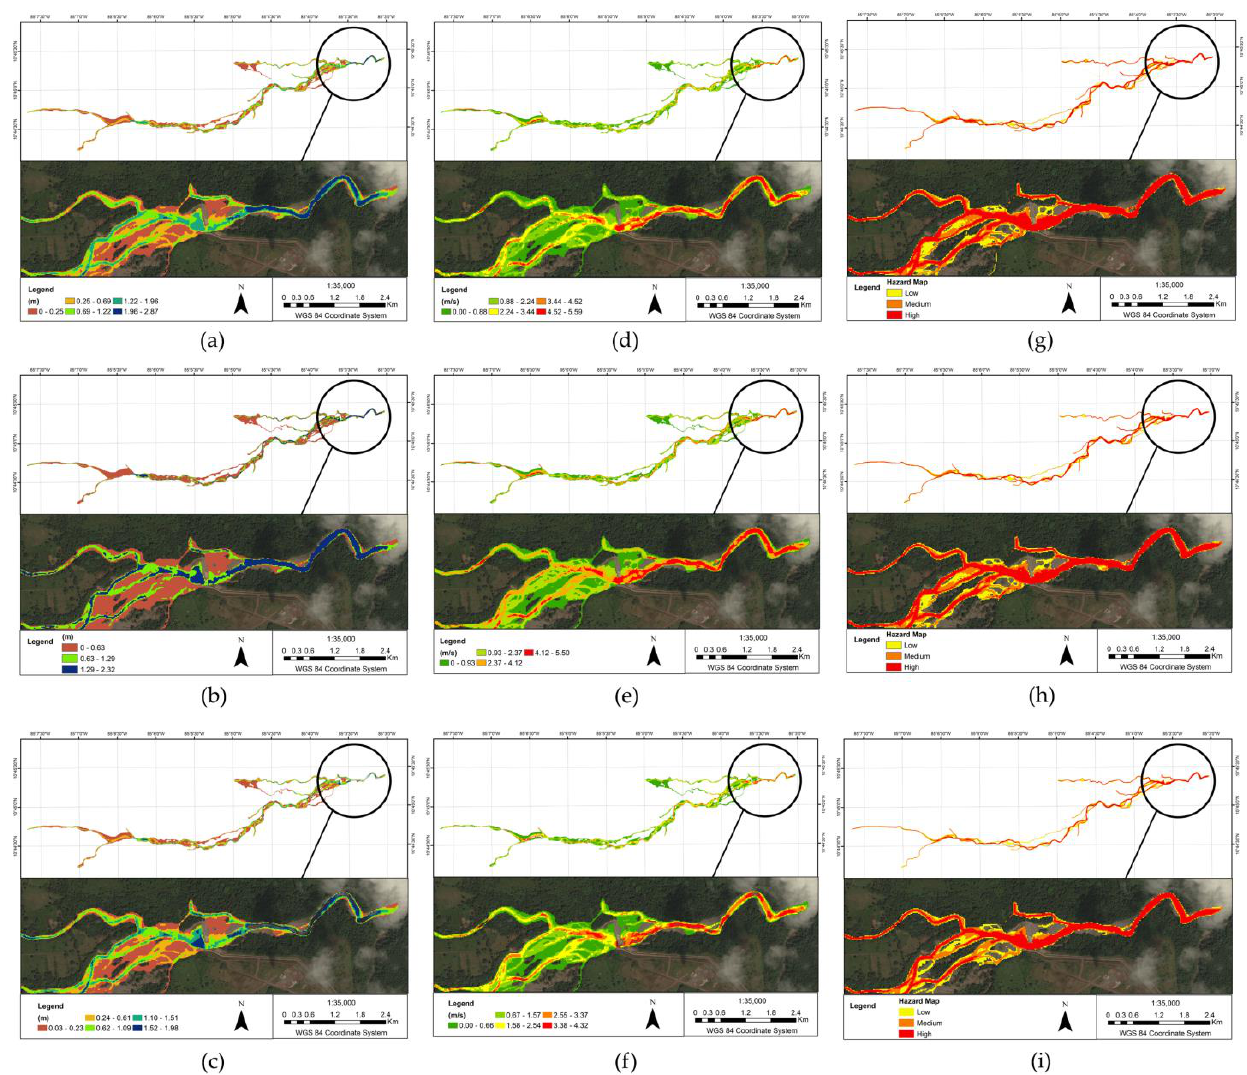
Figure 4. Maps for clean-water modeling for Hurricane Otto using a rain gauge, 100-year return period, and Hydro-Estimator: ( a – c ) flood depth maps, ( d – f ) flood velocity maps, ( g – i ) flood hazard maps.